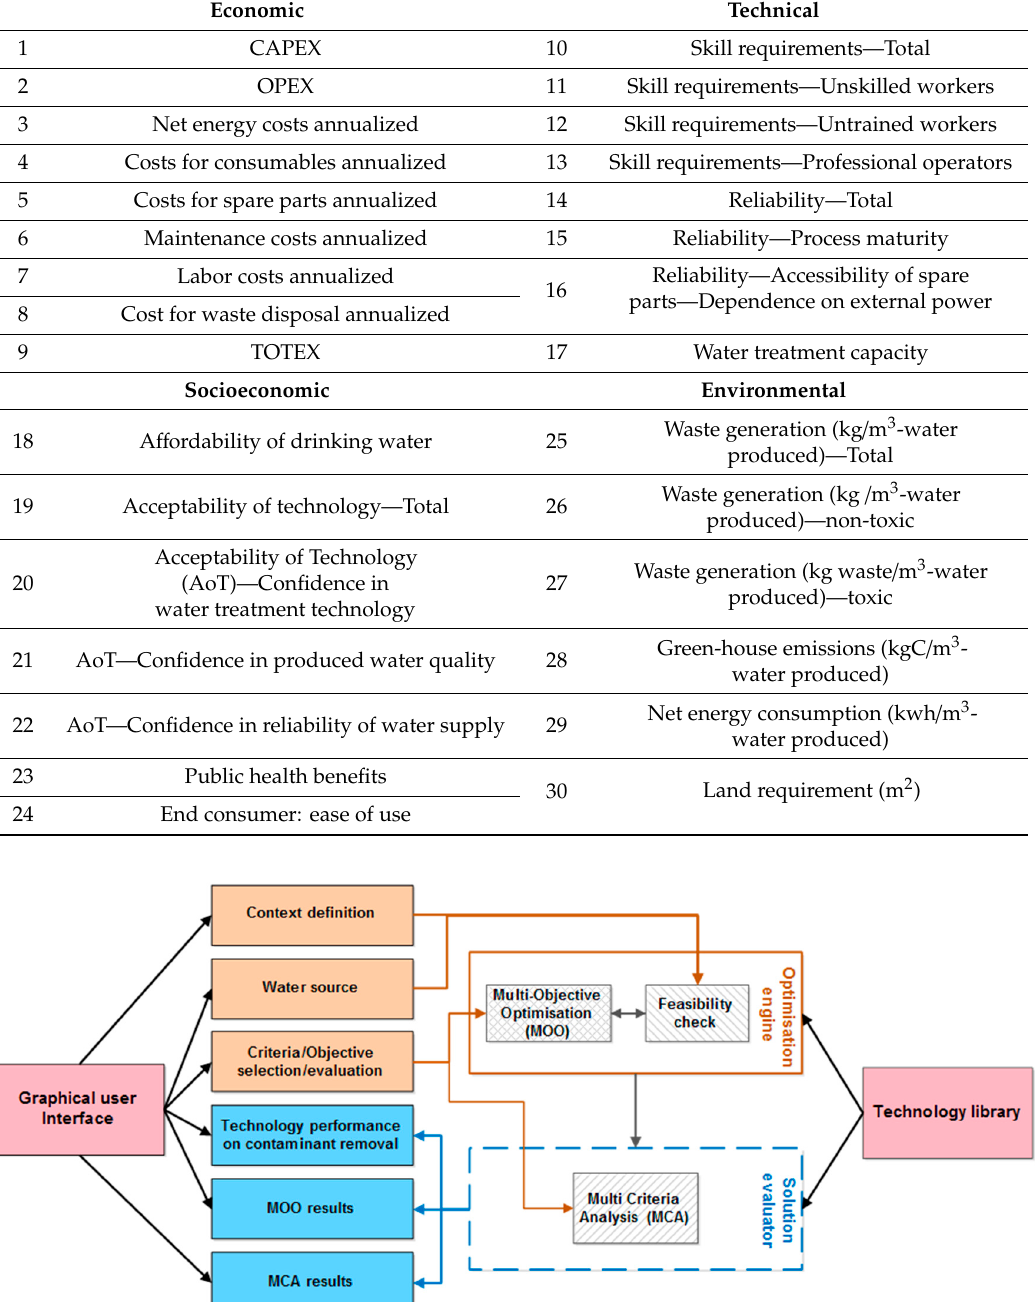
Figure 1. Overview of WETSUiT (WatEr Treatment decision SUpport Tool) Structure and main components of this tool.